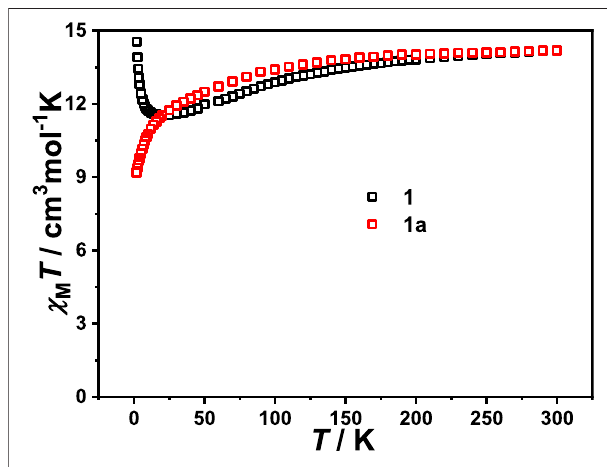
FIGURE3 | Theplots of χ M T versus T for 1 and 1a under anapplied fi eld of 1 kOe.